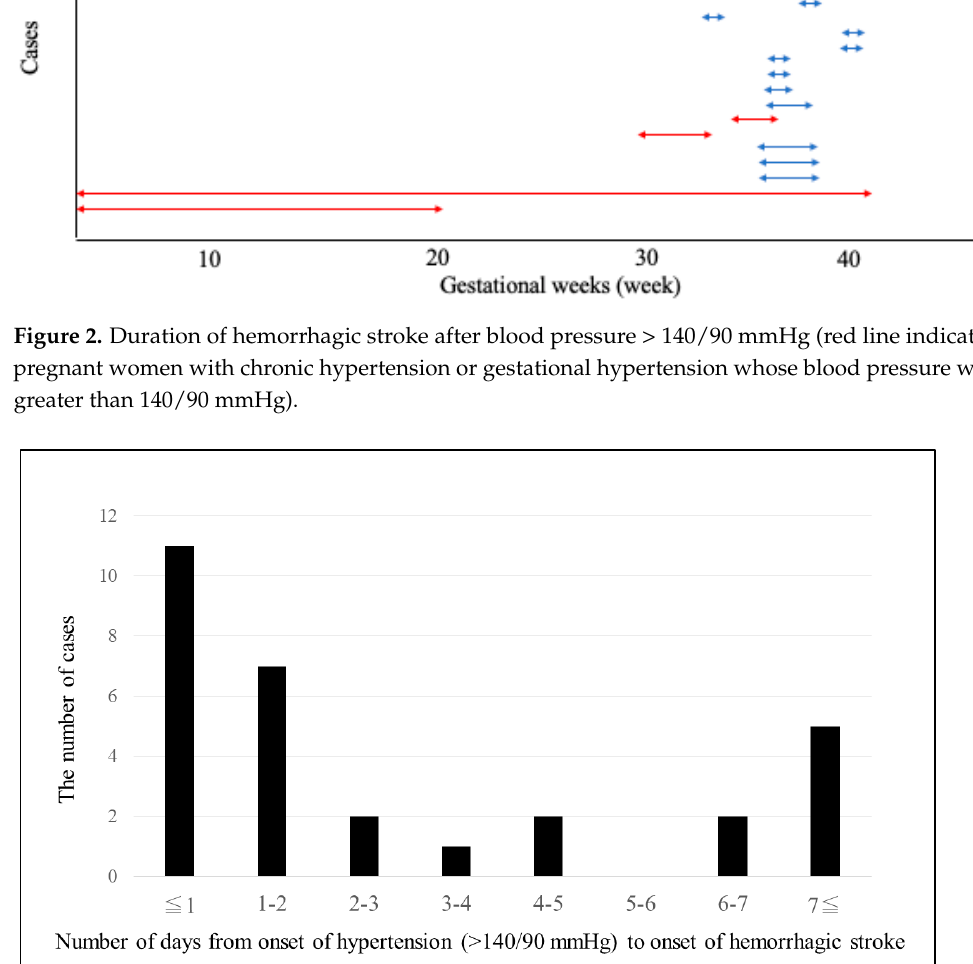
Figure 3. Time from BP elevation (>140/90 mmHg) to cerebral hemorrhage in 30 patients with proteinuria whose BP did exceed 140/90 mmHg between 14+0 and 33+6 weeks of gestation and whose BP did not exceed 140/90 mmHg between 14+0 and 33+6 weeks of gestation.